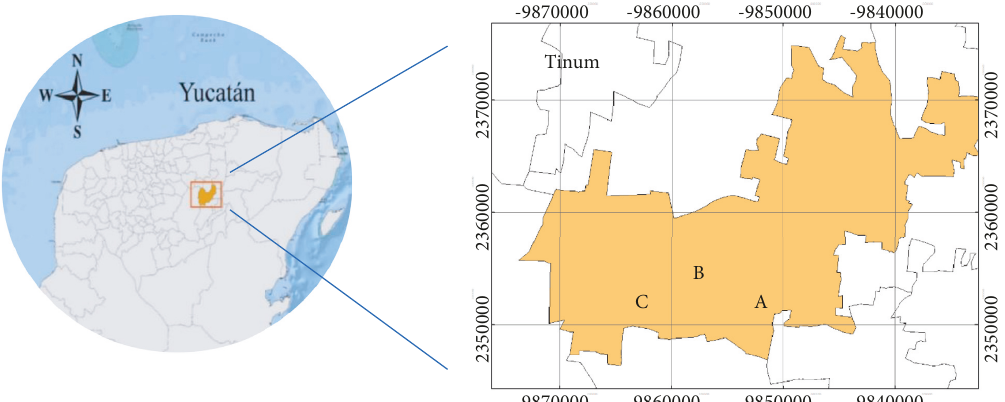
Figure 1: Geographical locations of the trapping sites in the municipality of Tinum, Yucatan. (a) A forest fragment. (b) An abandoned cornfield. (c) A perirural